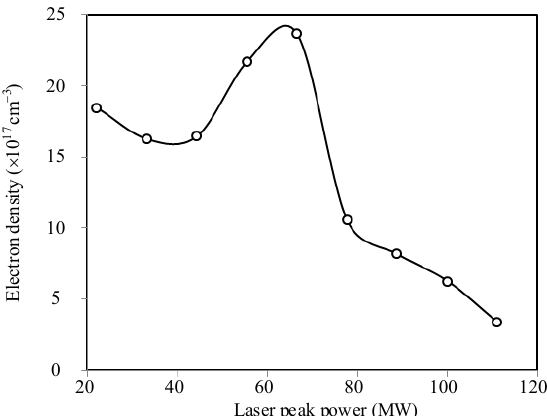
Fig. 4 Variation of electron density of laser-induced tin plasma with laser peak